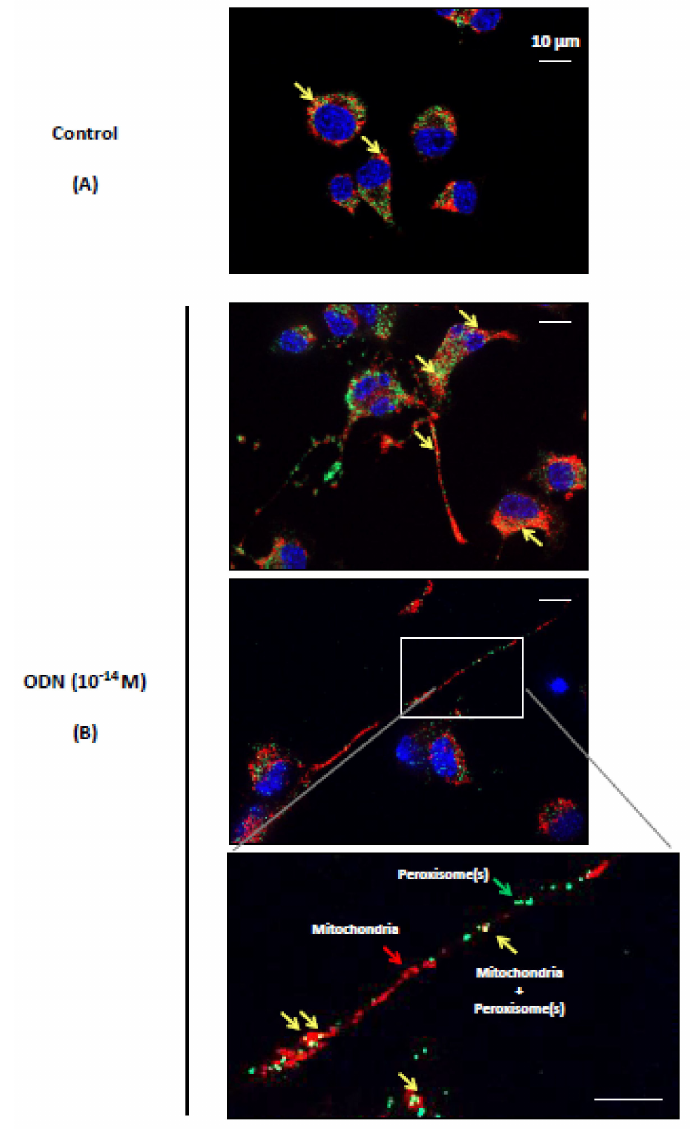
Figure 3. Visualization of mitochondria and peroxisomes in ODN-treated N2a cells. Murine neuronal N2a cells were previously cultured for 24 h in conventional cultured medium; the cells were further cultured for 48 h in medium without FBS in the absence (control, ( A )) or presence of octadecaneuropeptide (ODN; 10 − 14 M, ( B )). The mitochondria were detected with Mitotracker Red (red fluorescence) and the peroxisomes by indirect immunofluorescence after staining with an antibody raised against the ABCD3 peroxisomal transporter revealed with 488-Alexa (green fluorescence). The nuclei were counterstained with Hoechst 33342 (2 µ g / mL). The images were acquired under a fluorescent microscope coupled with an Apotome (Zeiss). No neurites (dendrites and / or axons) are detected in control cells ( A ) whereas very long neurites were observed in ODN-treated cells ( B ). Along the neurites, several mitochondria (red fluorescence) and peroxisomes (green fluorescence) were detected. Yellow spots (colocalization of mitochondria and peroxisomes) were also detected. Green arrows point towards peroxisomes; red arrows point towards mitochondria; yellow arrows point towards colocalized peroxisomes and